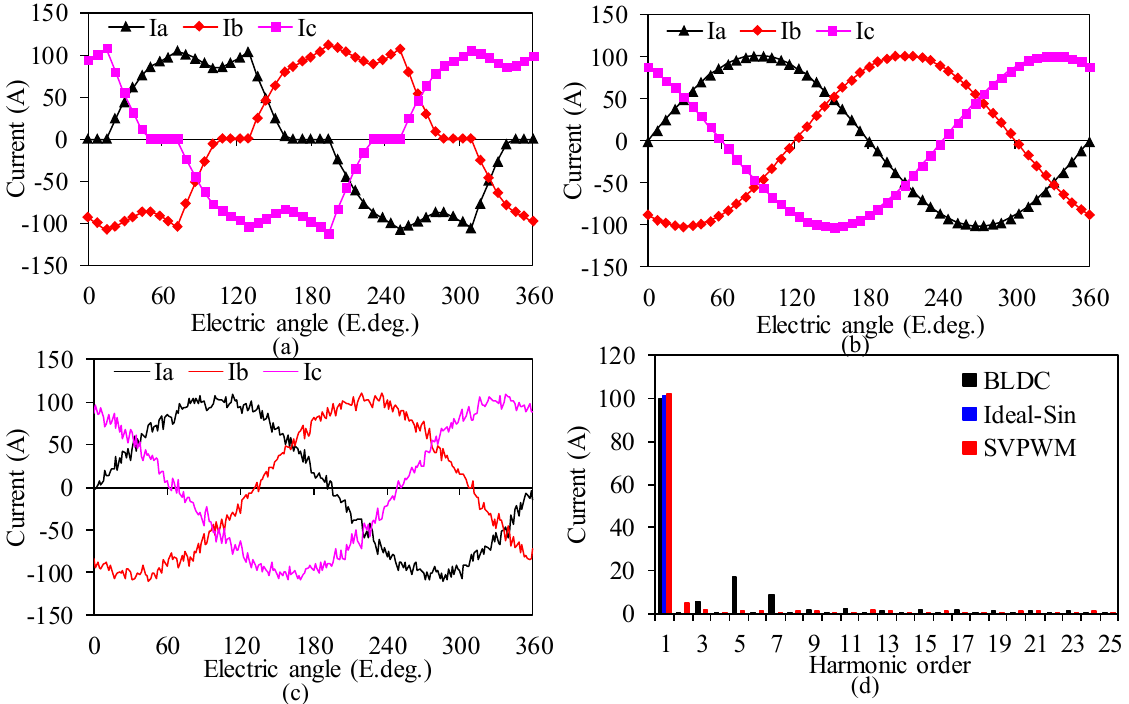
Figure 6. The current and harmonic content of different driving methods. ( a ) BLDC, ( b ) Ideal-Sin, ( c ) SVPWM, ( d ) Current THD.